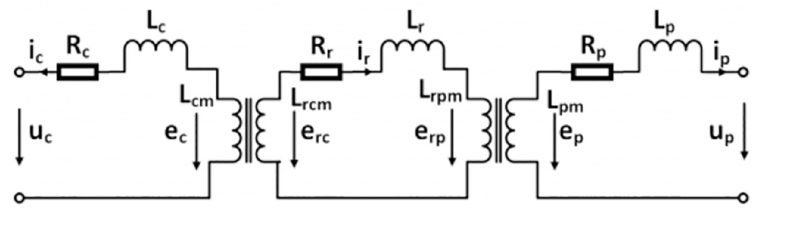
Fig 1. BDFIG equivalent circuit.